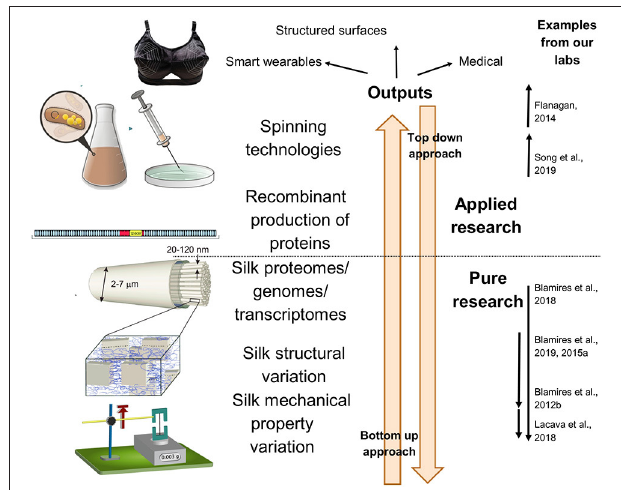
FIGURE 1 | An overview of the components and working principals of a complete and multidiscipline biomimetics research program aiming to develop wearable technologies, and other marketable materials, based on the structures, and functions of spider silks. It shows how combining pure and applied research can produce outcomes and the distinctions between taking top down (starting at the application to search for a natural function) and bottom up (i.e., observing a function and then ask questions of its application) approaches. Examples of research from our laboratories is given for each level.